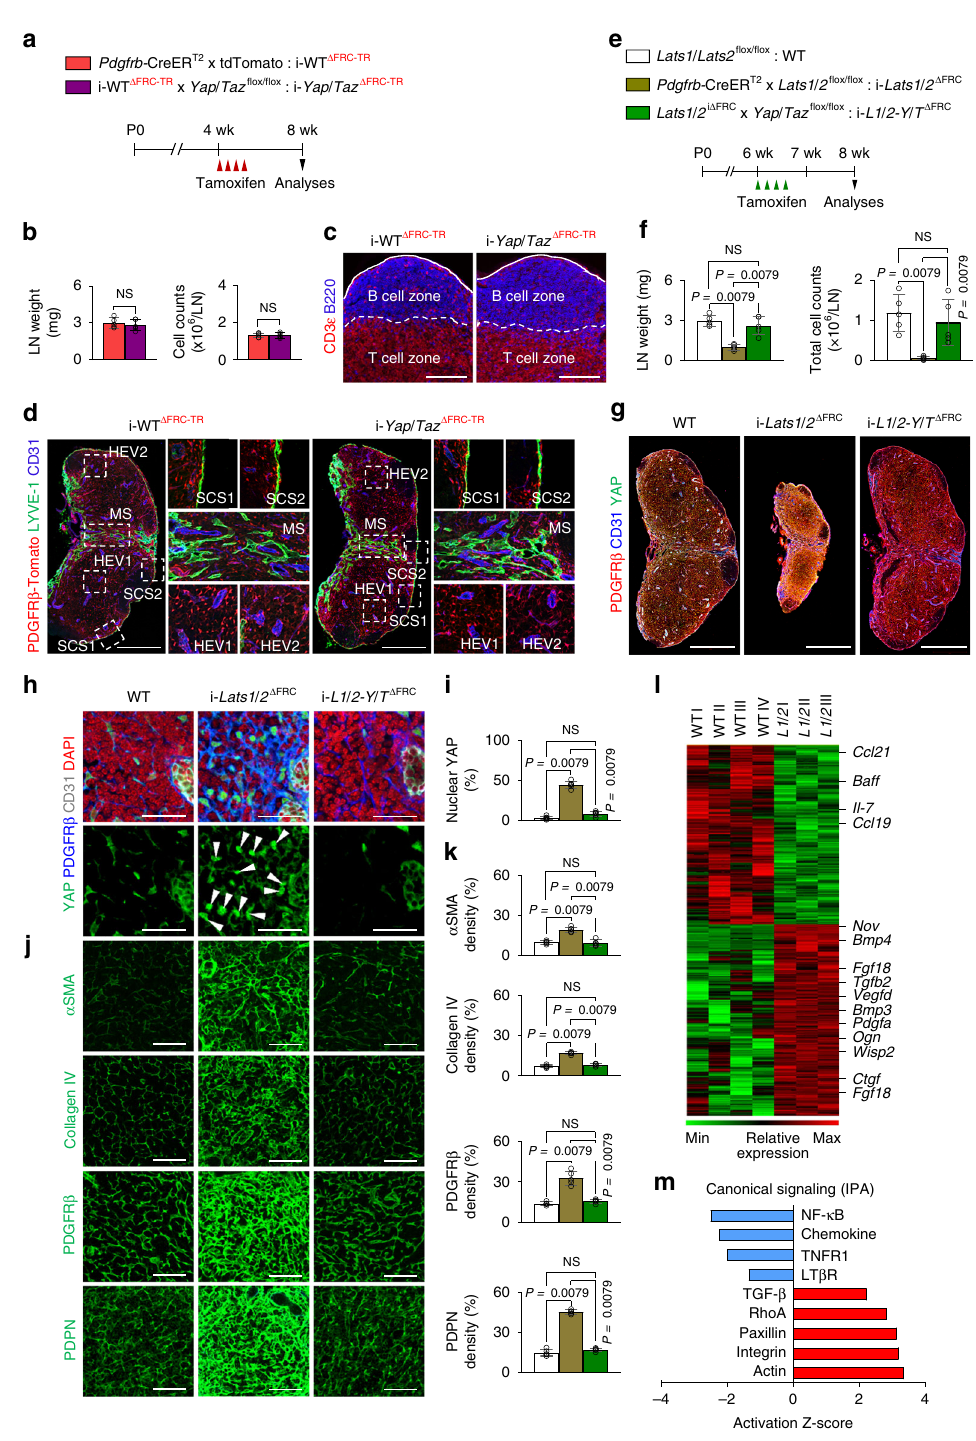
Fig. 14a). Of note, all the perilipin + or BODIPY + adipocytes were YFP + in LNs of Ltbr-Y / T Δ FRC-YR and i- Ltbr-Y / T Δ